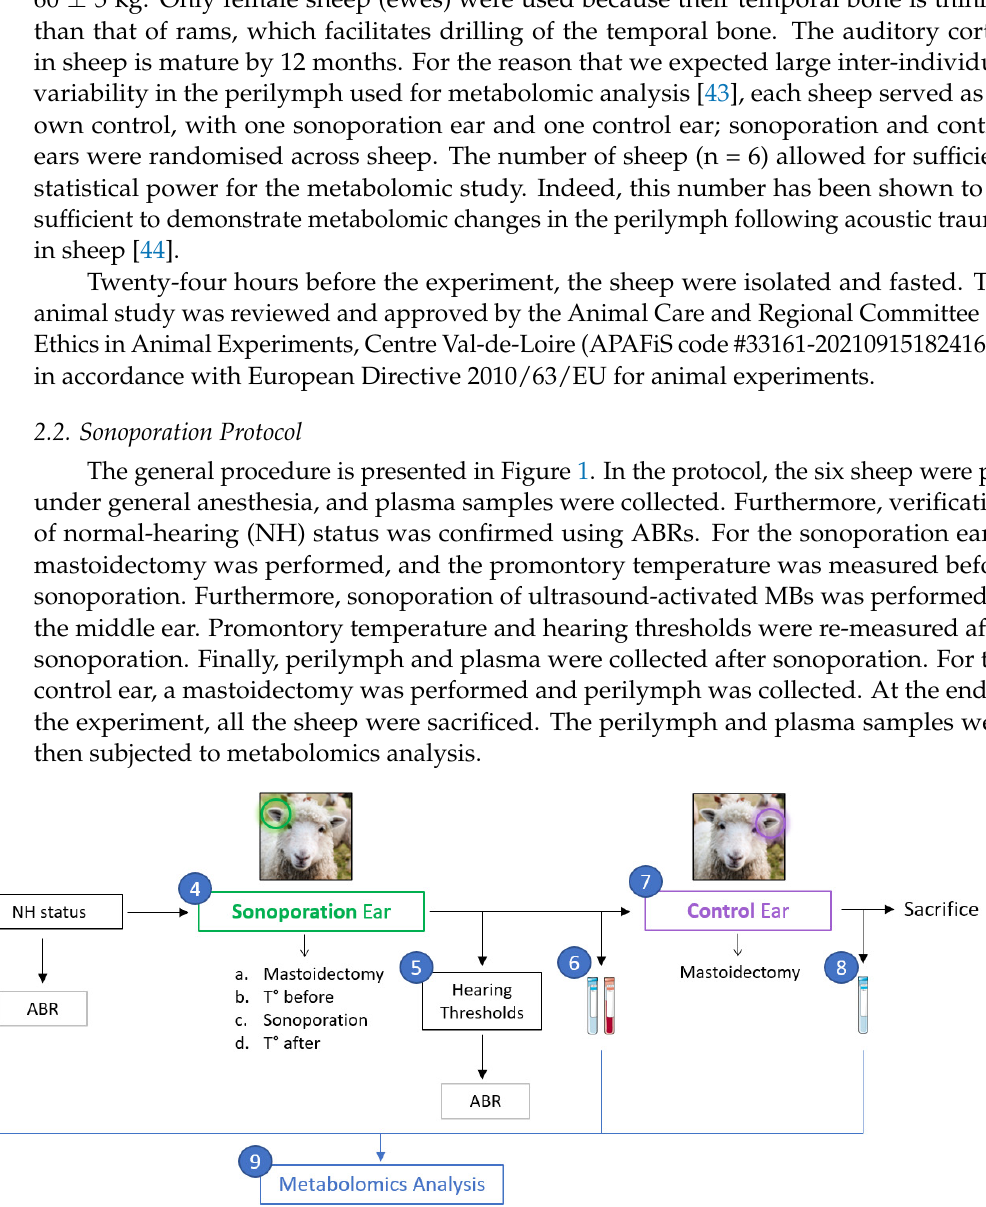
Figure 1. Study protocol. (1) 6 sheep under general anesthesia. (2) Plasma sample after anesthesia (before sonoporation). (3) Verification of NH status using ABR. (4) Sonoporation ear: a. Mastoidec- tomy, b. Measure of promontory temperature before sonoporation, c. Sonoporation of ultrasound activated MBs injected into the middle ear, and d. Verification of promontory temperature after sonoporation. (5) Verification of hearing thresholds. (6) Perilymph and plasma sampling. (7) Control ear: mastoidectomy. (8) Perilymph sampling before sacrifice of the animal. (9) Metabolomic analysis of the